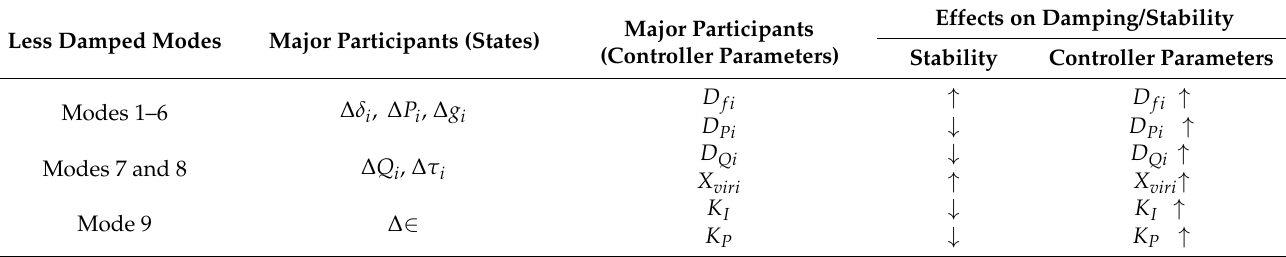
Table 1. System dynamics and stability analysis result.